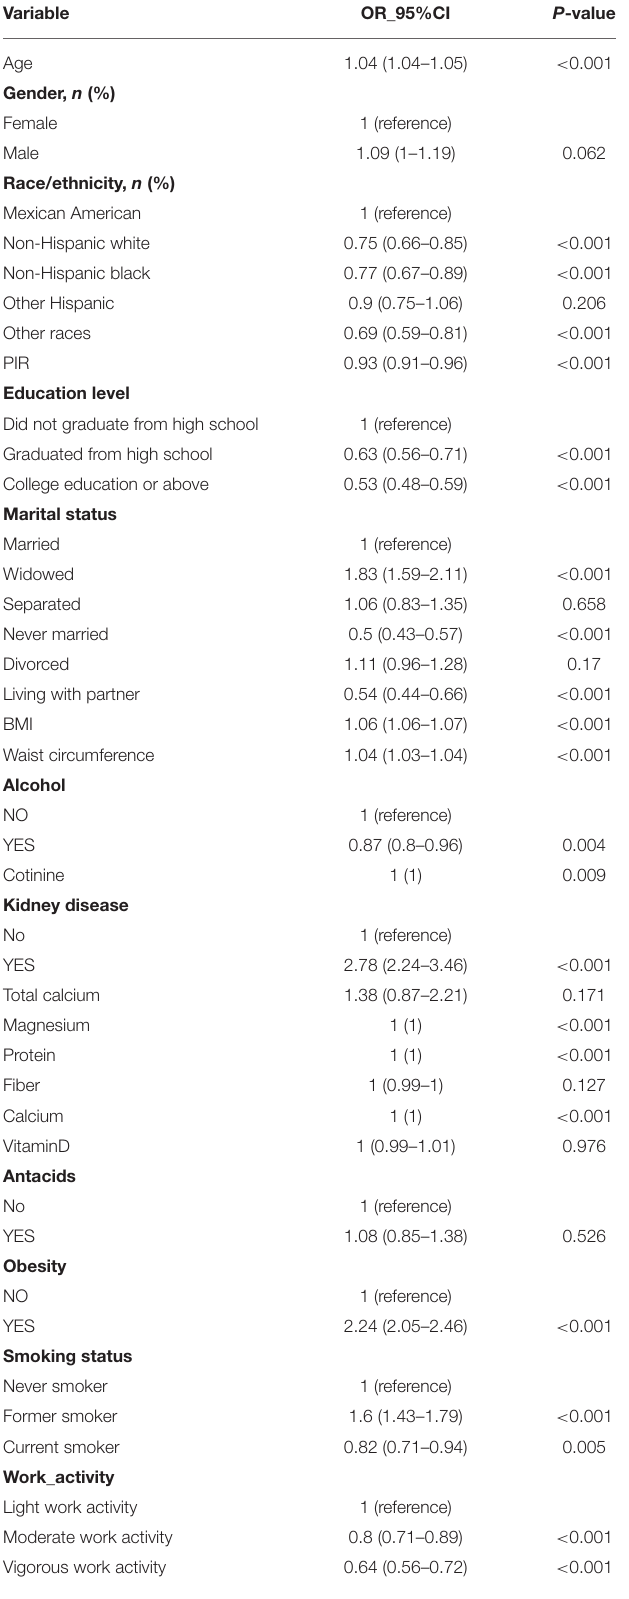
TABLE 2 | Association of covariates and type 2 diabetes risk. TABLE 3 | The associations between pesticide exposure in home and type 2 diabetes